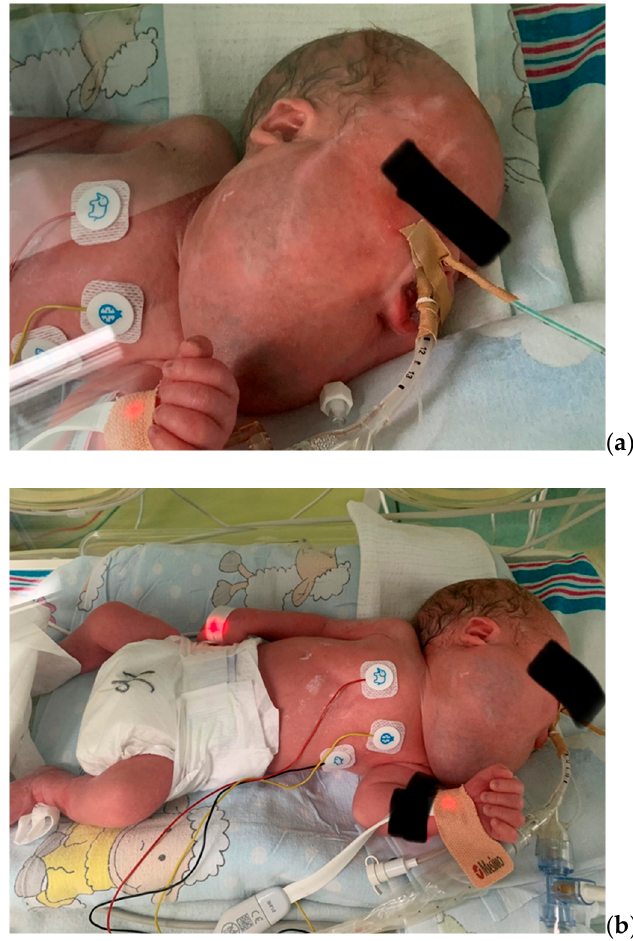
Figure 2. A transverse view of the fetal neck on malformation level on the 32nd week of gestation shows mixed echogenicity of the lesion with cystic and solid components.